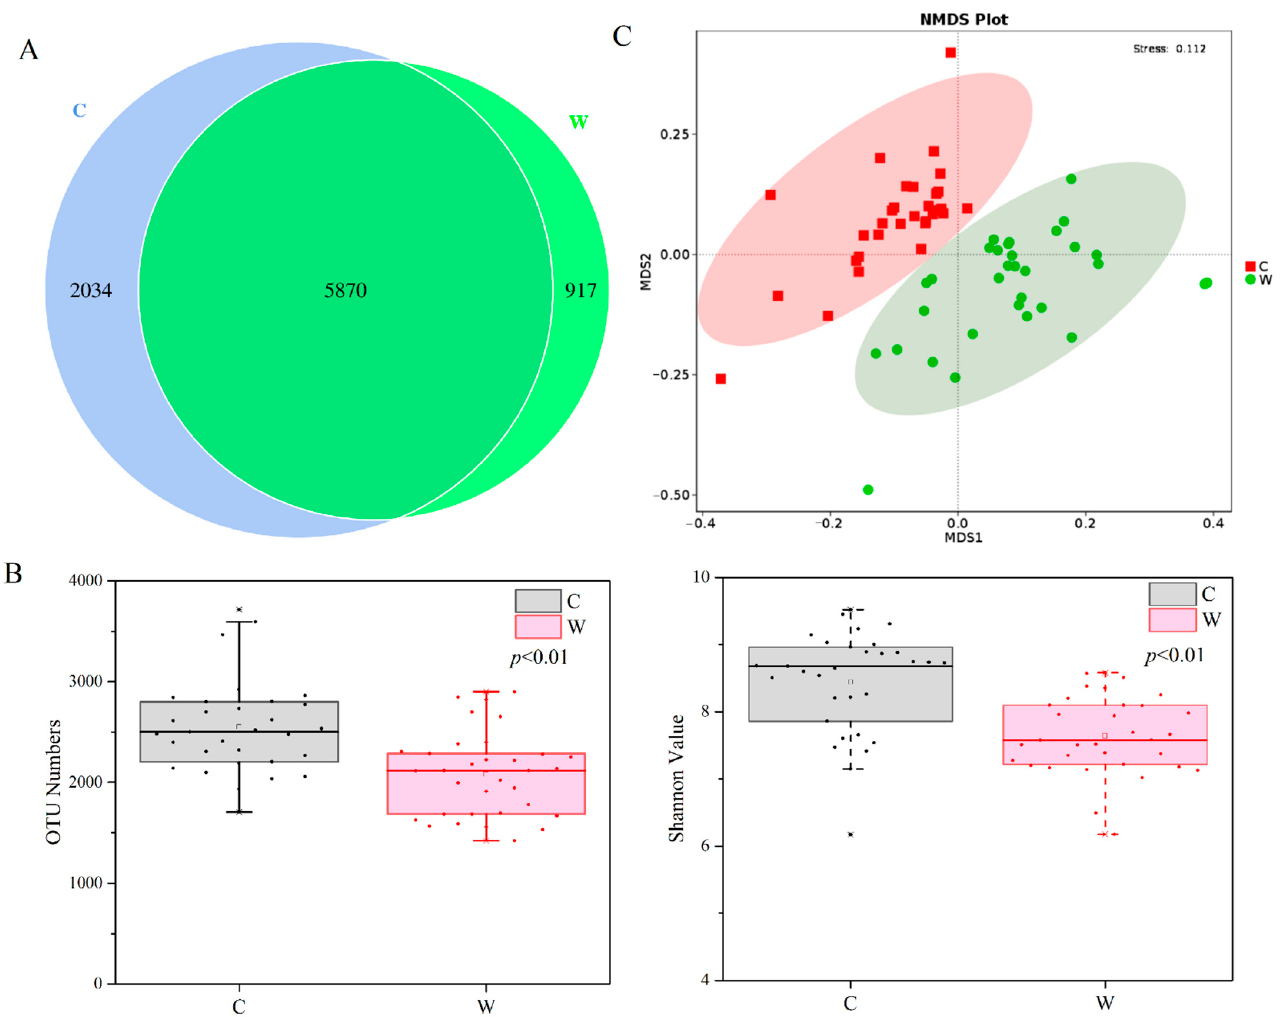
Figure 2. Venn diagram of microbial operational taxonomic units (OTUs) ( A ). Plots of α -diversity (OTU richness and Shannon index) between concrete and wood ( B ). Non-metric multidimensional scaling (NMDS) plots of microbial communities of concrete and wooden samples based on Bray–Curtis distances ( C ).